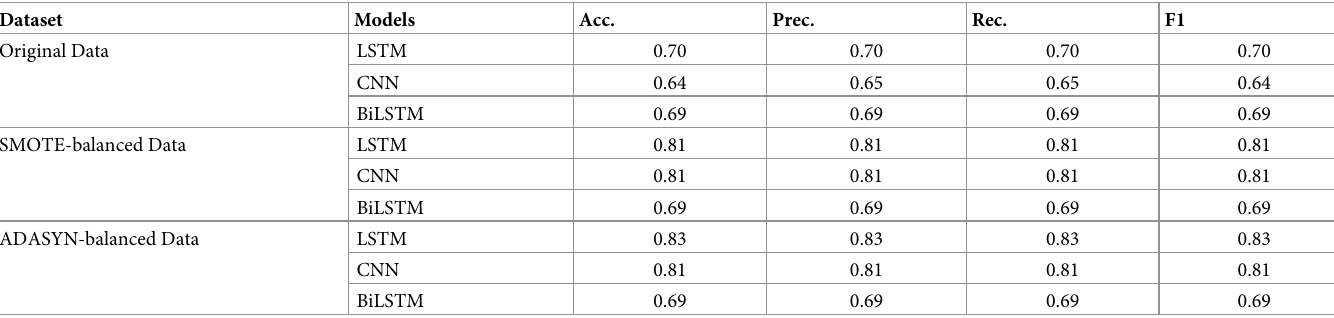
Table 13. Classification results of deep neural networks without SMOTE. Dataset Models Acc. Prec. Rec. Original